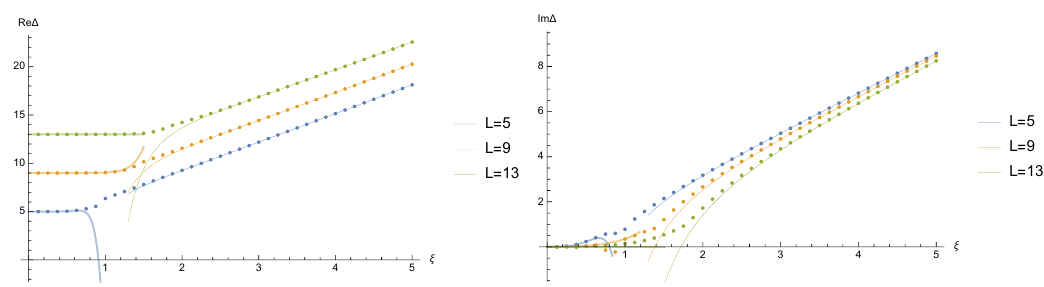
Figure 14 . Real and imaginary parts of the dimension (cid:1)( (cid:24) ) as a function of (cid:24) for the states with L = (cid:1)(0) = 5 ; 9 ; 13. Dots represent the numerical data, this line is given by our quasi-classical prediction (8.65) with N = 1 ; 3 ; 5 correspondingly. The thick line is the weak coupling prediction. tions (cid:1)( (cid:24) ) (see (8.24)). We verify that at large (cid:24) these functions have a correct